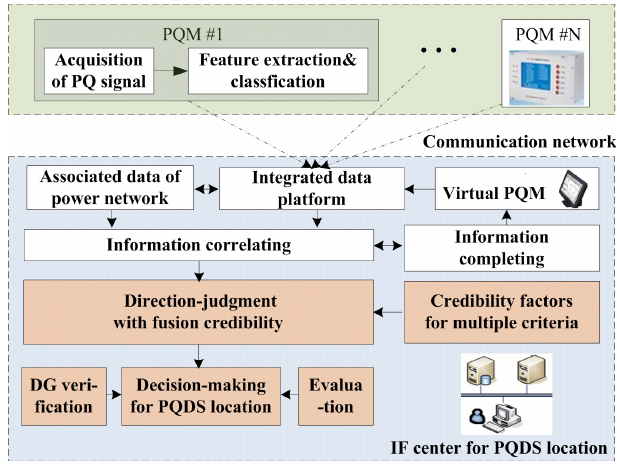
Figure 3. Overall framework of the proposed